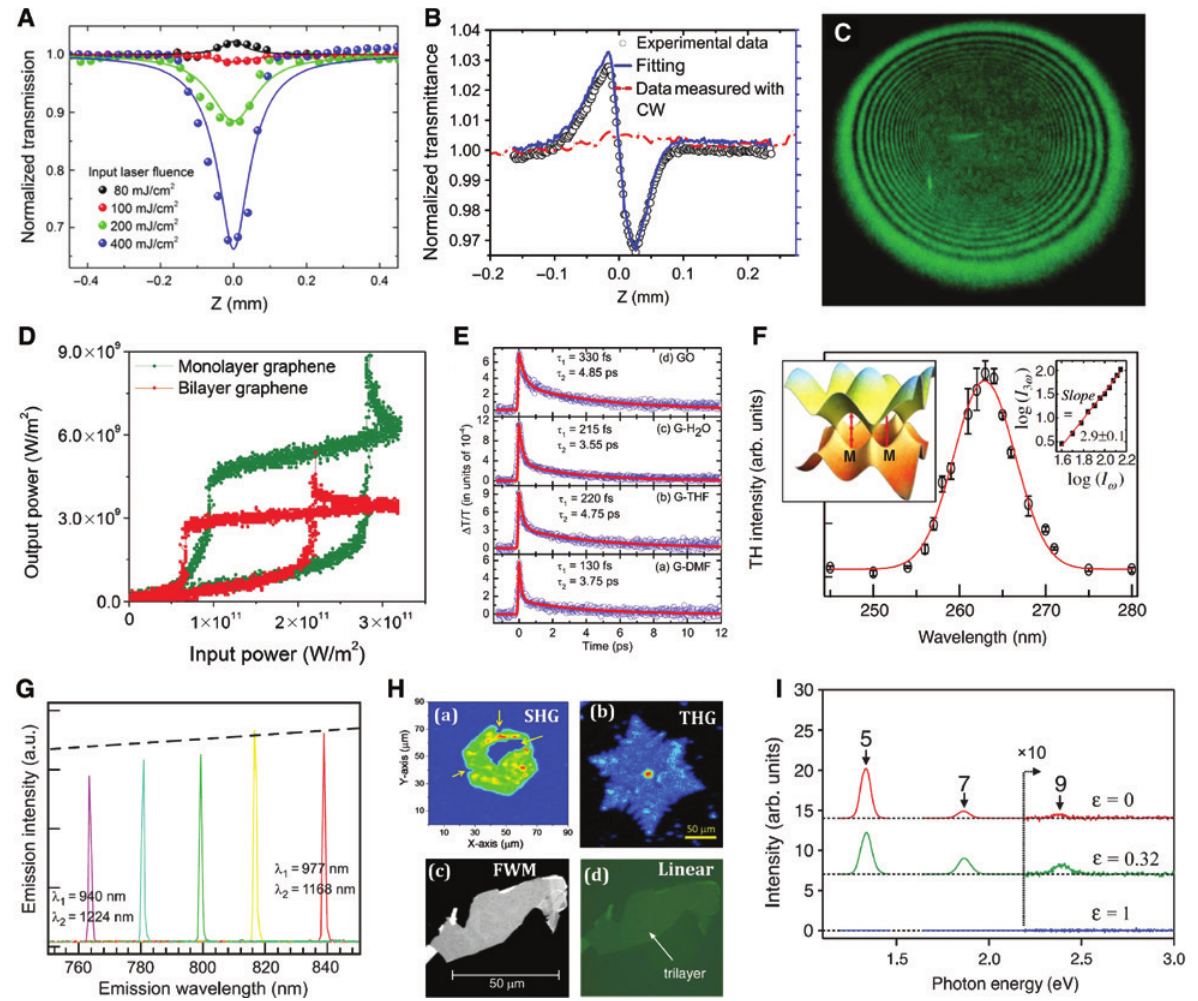
Figure 8: Nonlinear optics of graphene. (A) Open aperture Z -scan curves of electrochemical graphene at various pump fluence. Reprinted from Ref. [67], with permission from AIP Publishing. (B) Closed aperture Z -scan curve of graphene with positive phase shift. Reprinted with permission from Ref. [112]. Copyright 2012 Optical Society of America. (C) Photograph of SPM diffraction ring pattern of FL graphene ( < 10) dispersion solution under excitation of 532 nm CW laser. Reprinted with permission from Ref. [66]. Copyright 2011 American Chemical Society. (D) Optical bistable hysteresis loops of SL and BL graphene. Reprinted with permission from Ref. [116]. Copyright 2015 John Wiley and Sons. (E) Degenerate PP decay curves of graphene in various solvents: (a) graphene in dimethylformamide (G-DMF), (b) graphene in tetrahydrofuran (G-THF), (c) graphene in water (G-H O), and 2 (d) GO in water (GO). Reprinted from Ref. [113], with permission from AIP Publishing. (F) THG spectrum of SL graphene excitation at 789 nm. (Left inset) Electronic band structure of graphene, including a three-photon resonance at the exciton-shifted graphene M saddle point. (Right inset) Log-log plot showing a cubic power dependence of the TH signal intensity ( I ) with respect to the intensity of the fundamental beam 3 ω ( I ). Reprinted with permission from Ref. [29]. Copyright 2013 American Physical Society. (G) FWM emission spectra of SL graphene for various ω combinations of pump wavelengths. The dashed line represents the wavelength dependence predicted by the nonlinear quantum response theory. Reprinted with permission from Ref. [60]. Copyright 2010 American Physical Society. (H) NLO imaging of graphene. (a) SHG image of suspended SL graphene. Reprinted from Ref. [114], with permission from AIP Publishing. (b) THG image of SL graphene and bright spot at center corresponding to the BL [29]. Copyright 2017. (c and d) FWM and linear optical images of FL graphene sheets, respectively. Reprinted with permission from [60]. Copyright 2010 American Physical Society. (I) HHG spectra of SL graphene for different ellipticity values of the pump laser ε = 0 (red curve), ε = 0.32 (green curve), and ε = 1 (blue curve) [115]. Copyright 2017 American Association for the Advancement of